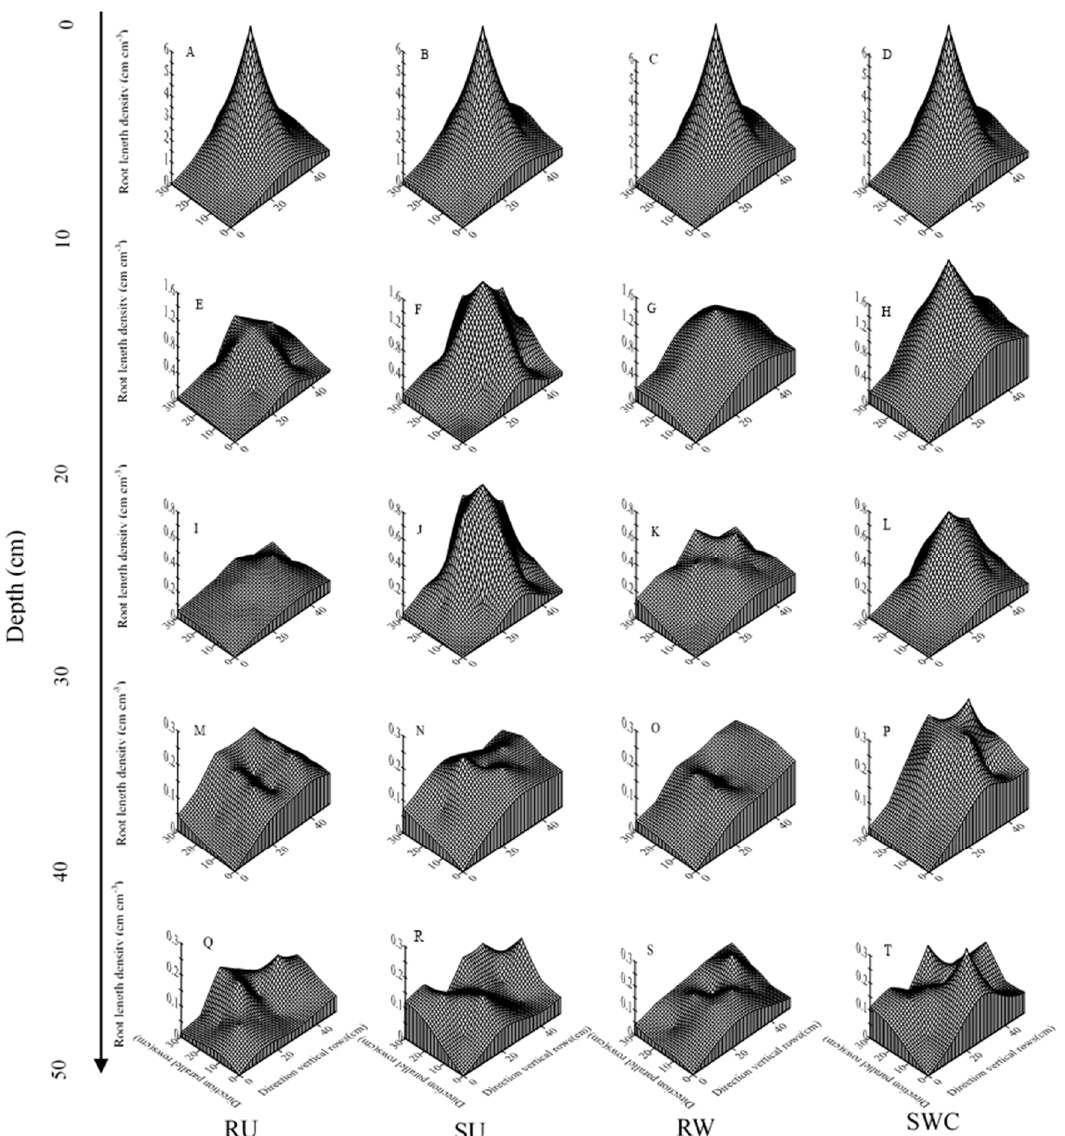
Figure 4. Horizontal distribution of root length density in the 0–50 cm soil layer at the R2 growth stage under different cultivation treatments in 2014. RU, rotary tillage plus uniform plant spacing (CK); SU, subsoil tillage plus with uniform plant spacing; RWC, rotary tillage plus wide–narrow plant spacing and chemical regulator; SWC, subsoil tillage plus wide–narrow plant spacing and chemical regulator application. A – D , distribution of root length density in the 0–10 cm soil layer; E – H , distribution of root length density in the 10–20 cm soil layer; I – L , distribution of root length density in the 20–30 cm soil layer; M – P , distribution of root length density in the 30–40 cm soil layer; Q – T , distribution of root length density in the 40-50 cm soil layer.